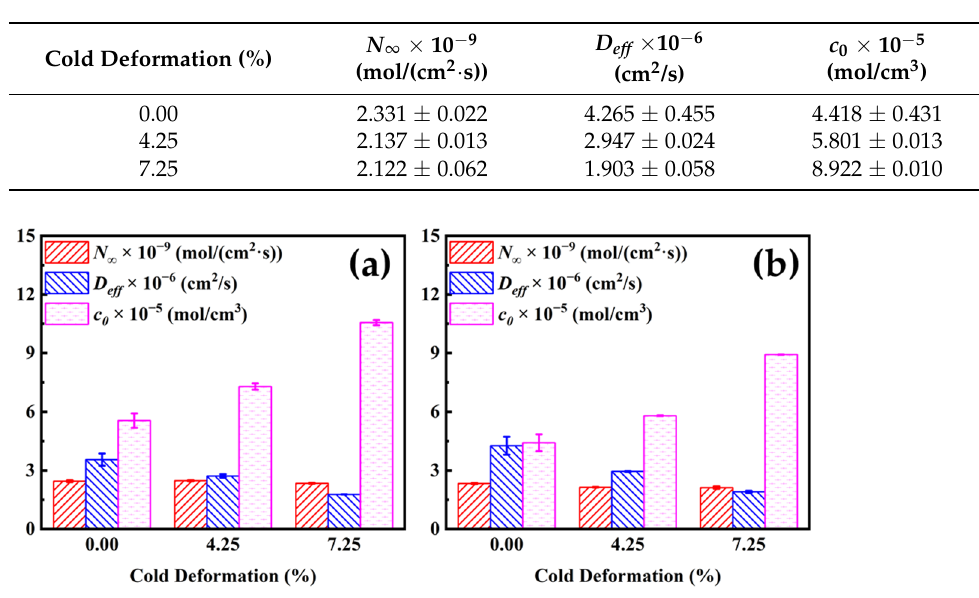
Table 3. Parameters from the second hydrogen permeation curves of X65 pipeline steel with different cold deformation levels.